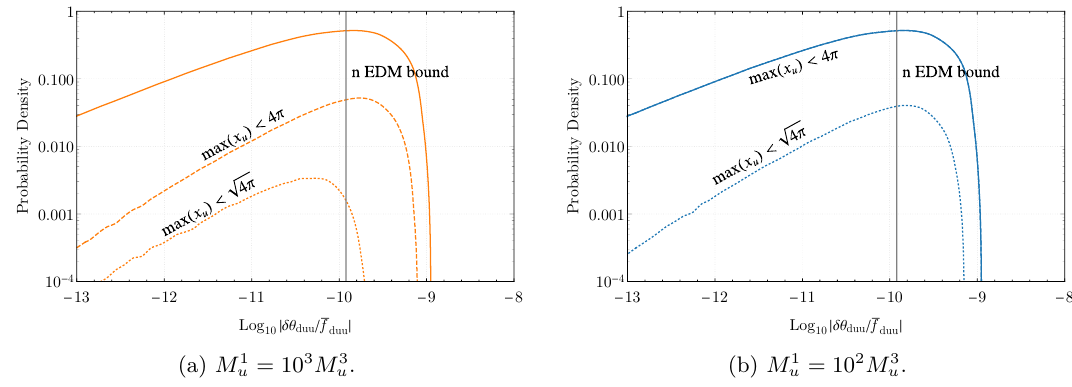
Figure 4. The probability density functions (PDFs) of | δθ duu | in eq. (5.2) with only b = 1 and c = 3 3 M 3 | (solid line). We take f M = f M d = M 1 normalized by a three-loop function | ¯ f 13 u = 10 u in (a) and duu f M = f M d = M 1 u = 10 2 M 3 u in (b). After imposing the perturbative unitarity bound of max ( x u ) < √ 4 π ( 4 π ) , the PDFs are expected by the dashed (dotted) lines. The areas of dashed and dotted lines are not normalized by one (see text). Note that the solid and dashed lines overlap in (b). If ¯ f 13 = 1 , duu the right area of the vertical line is excluded at 90% CL by the neutron EDM measurement (1.1).